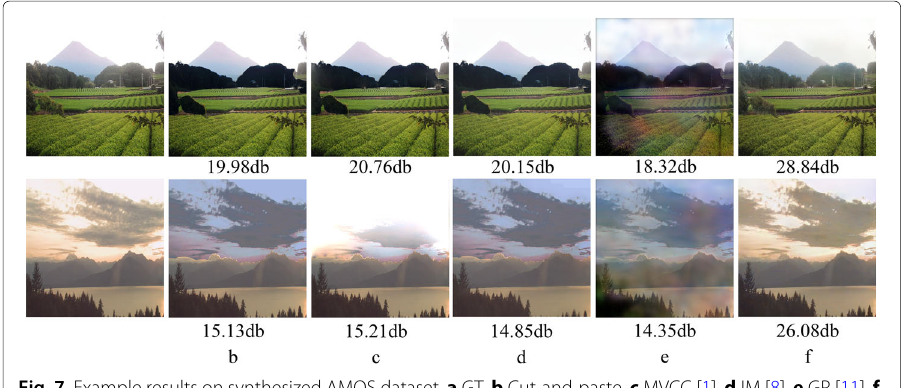
Fig. 7 Example results on synthesized AMOS dataset. a GT. b Cut-and-paste. c MVCC [1]. d IM [8]. e GP [11]. f Our proposed network. Our composite results obtained the highest PSNR value